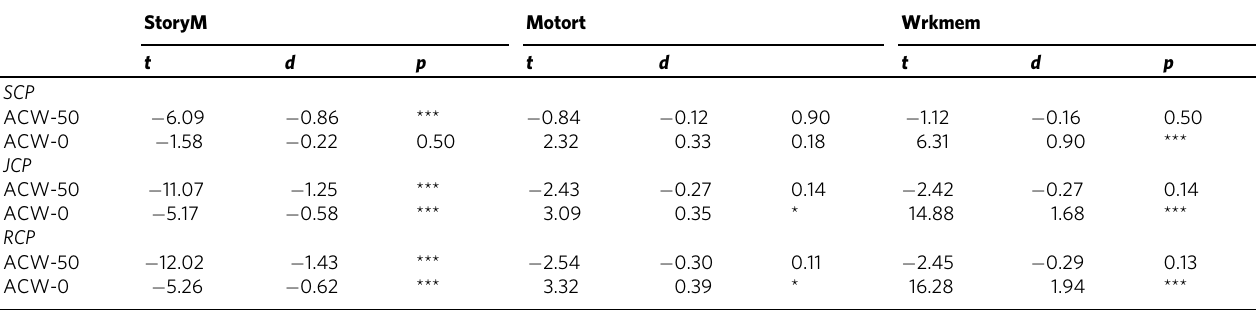
Table 2 Post-hoc results for periphery vs. core in the change from resting to task state. StoryM